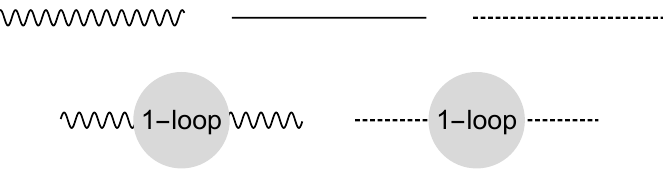
Figure 11. Above: the tree propagators of gauge, scalar and fermionic (cid:12)elds. Below: the one-loop propagators of gauge and fermionic (cid:12)elds, respectively.